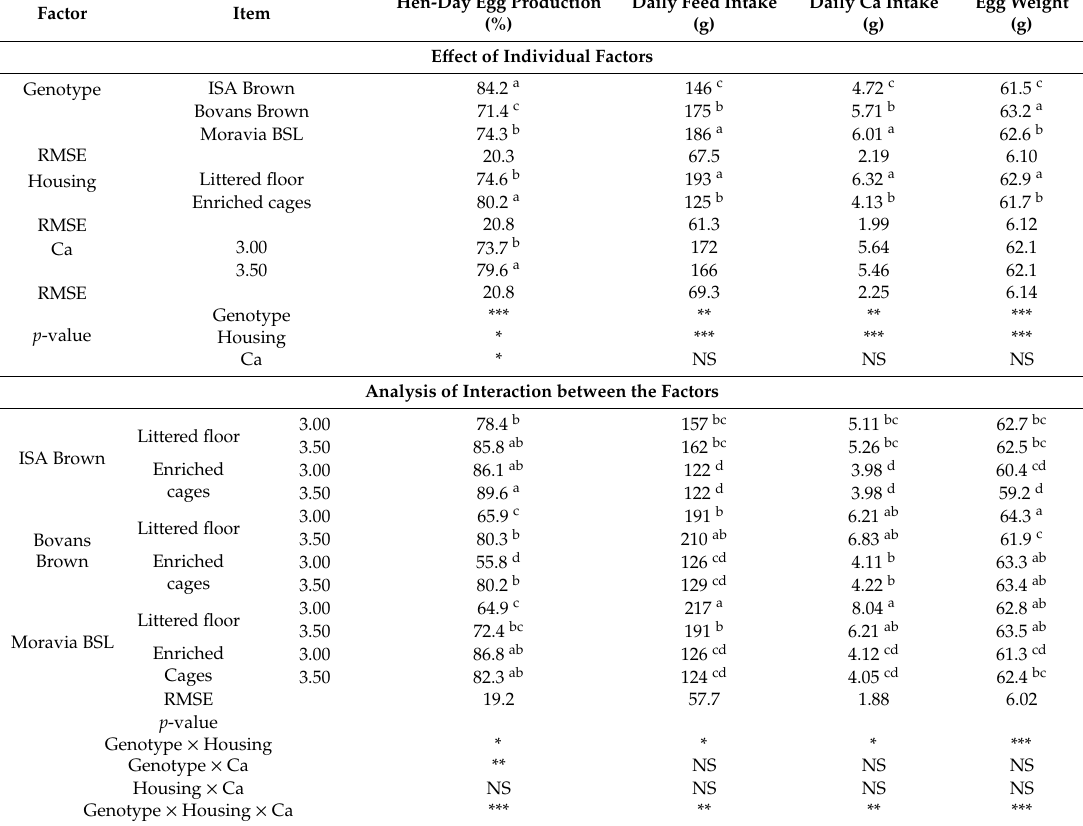
Table 2. The e ff ects of genotype, housing system, and feed Ca level and their interaction on hen performance parameters and egg